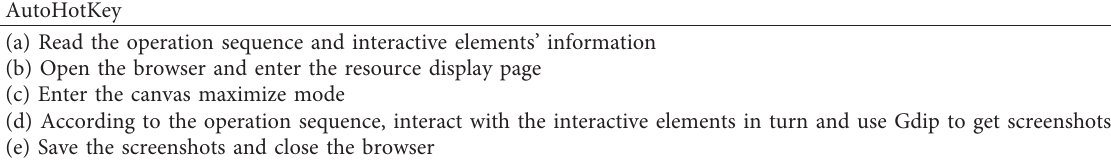
Table 5: Interaction process by AutoHotKey.